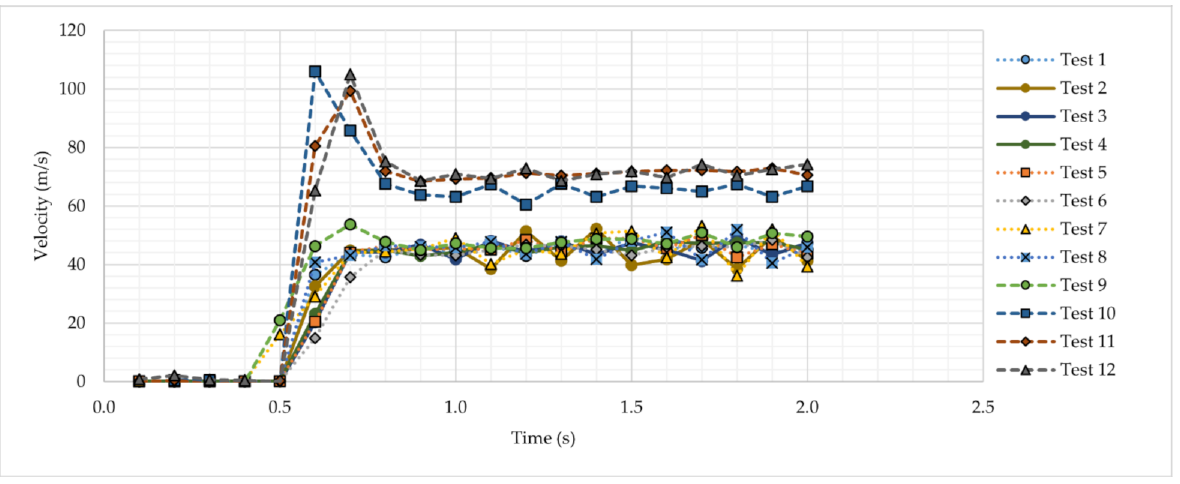
Figure 10. Calculated velocity through valve constriction using conservation of mass, corrected for valve lift